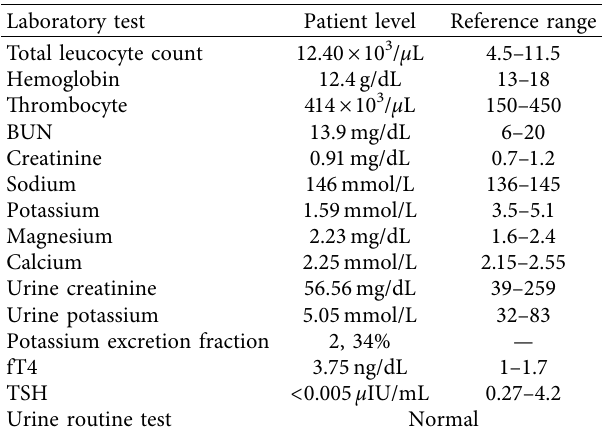
Table 2: Summary of the laboratory